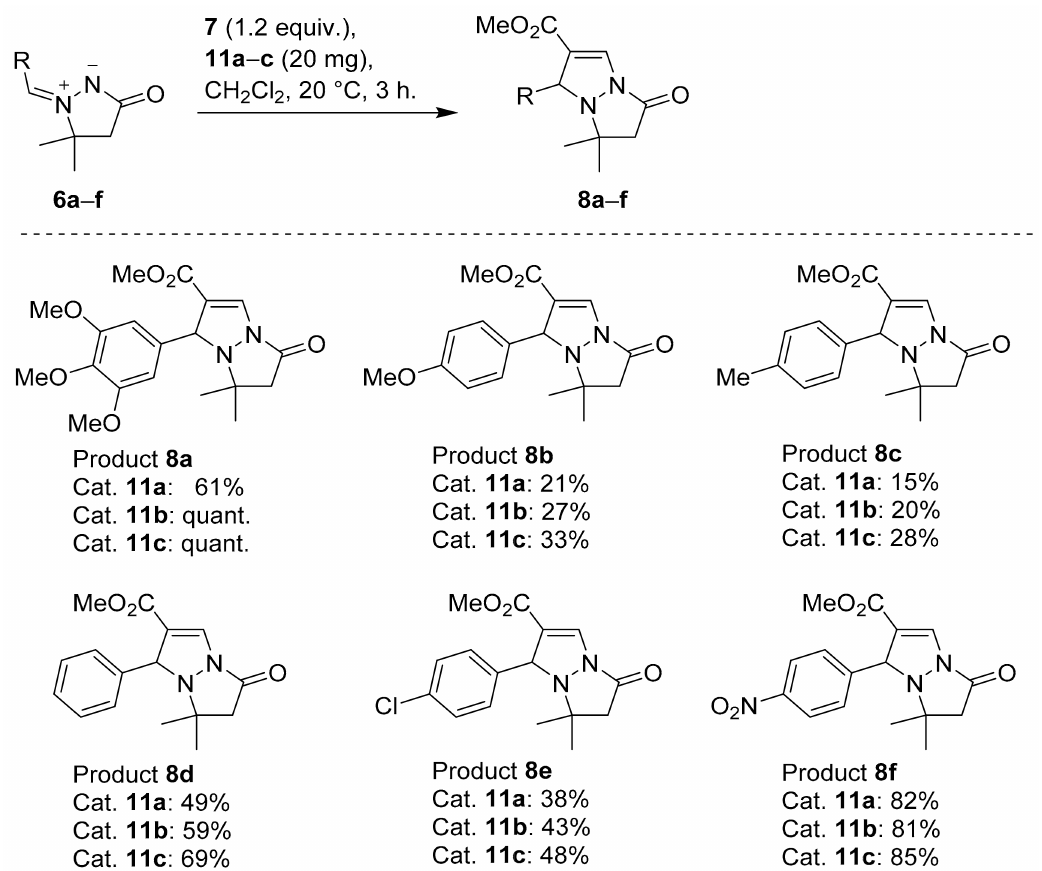
Scheme 4. The conversions in CuAIAC reactions of dipoles 6a – f with methyl propiolate ( 7 ) catalyzed by ~13 mol% of 11a–c . The conversions were determined by 1 H NMR of the crude reaction